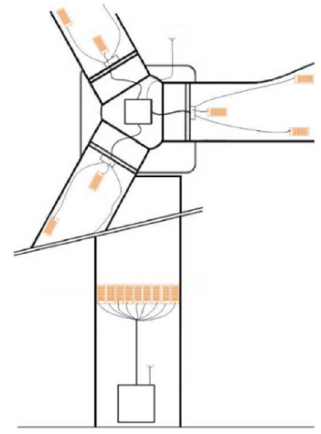
Figure 9. Sketch of the ultrasonic sensors placed on wind turbines [18].